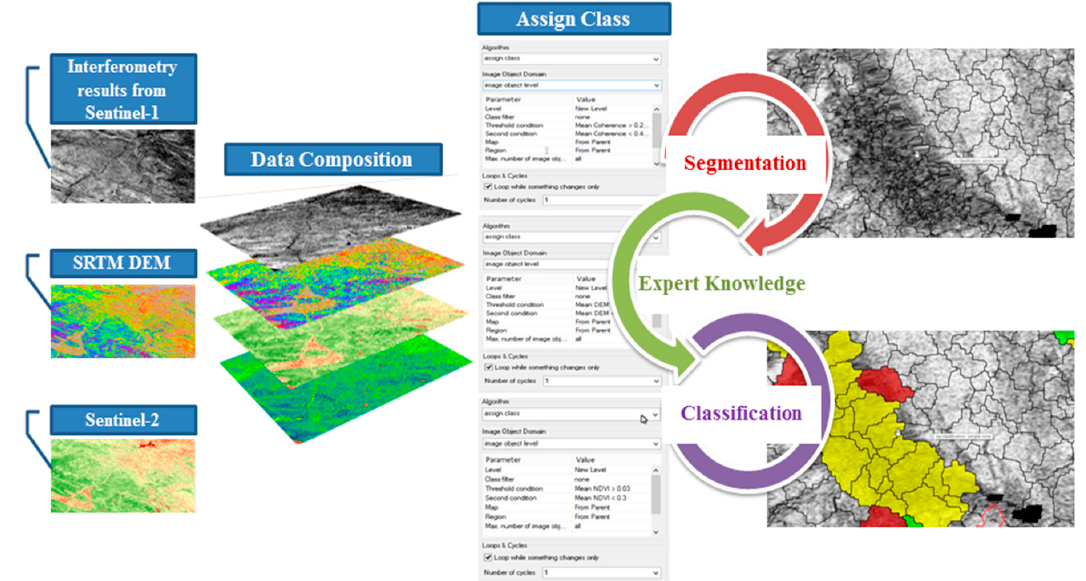
Figure 3. Workflow for landslide detection in the object ‐ based environment.